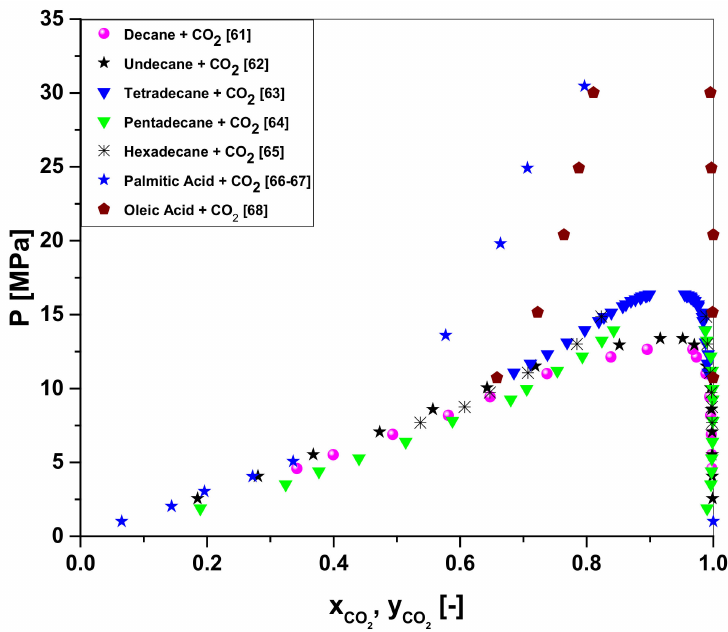
Figure 1. High-pressure phase equilibrium for the binary pairs OLP-compounds-i + CO 2 (decane + CO 2 , undecane + CO 2 , tetradecane + CO 2 , pentadecane + CO 2 , hexadecane + CO 2 , palmitic acid + CO 2 , and oleic acid + CO 2 ) described in the literature [61–68].